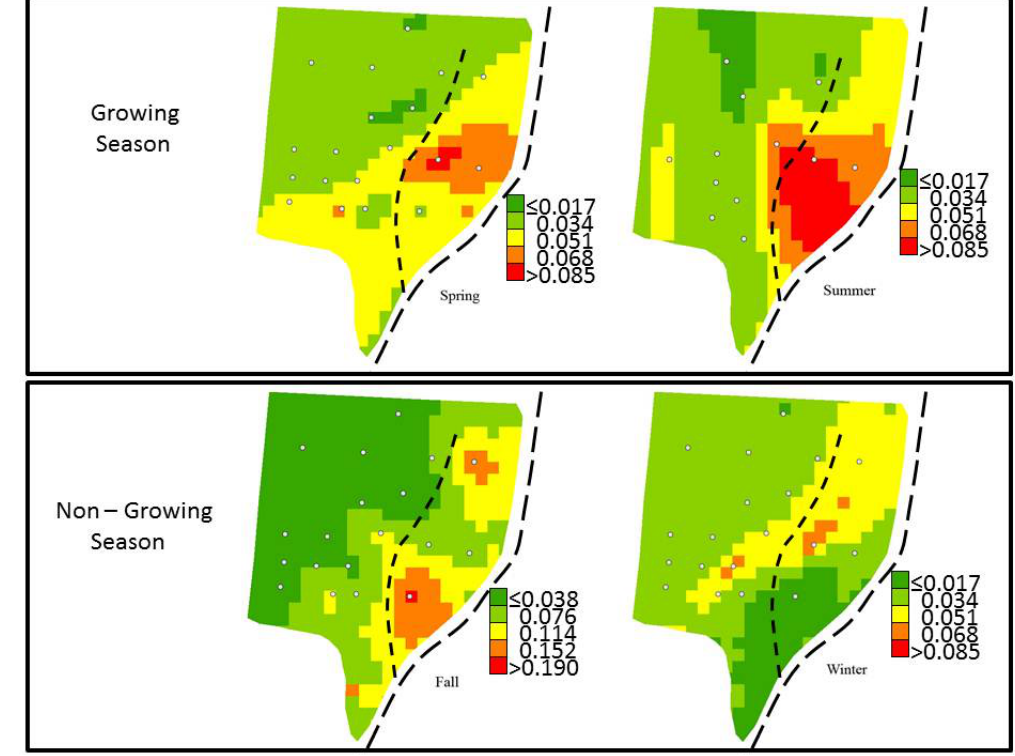
Figure 4. Estimated groundwater Soluble Reactive Phosphorous (SRP) concentration maps for the spring, summer, fall and winter. Spring, summer and winter maps have the same concentration scale for predicted values (mg L − 1 ), while the fall map does not. White dots represent the piezometers locations at the field site, the short dashed line represents Creek B, and the longer dashed line is the main stream course.